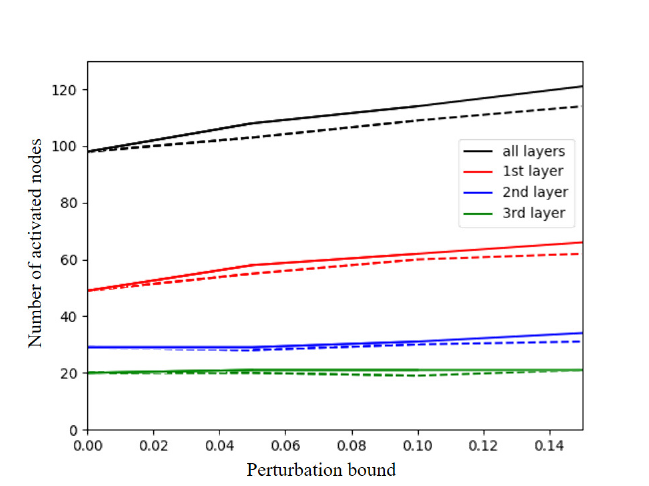
Figure 10: Relationship between perturbation bound and number of activated nodes crafted by AEs of proposed attack using data-dependent timing leaks (solid line) and random noise (dashed line) in one AE. Proposed attack can increase number of activated nodes with small perturbations decided by data-dependent timing leaks compared with random noise. The attack causes misclassification at 0.15